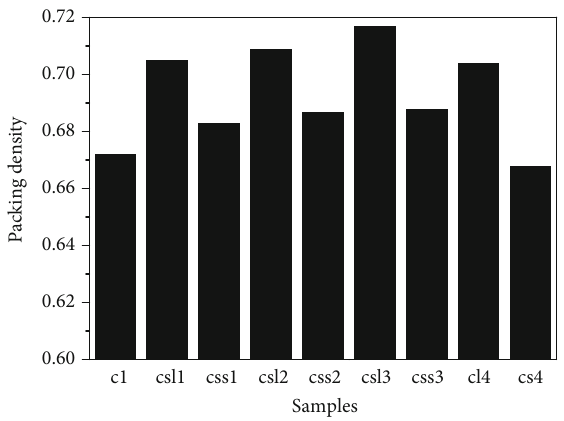
Figure 3: Comparison of particle size distributions.